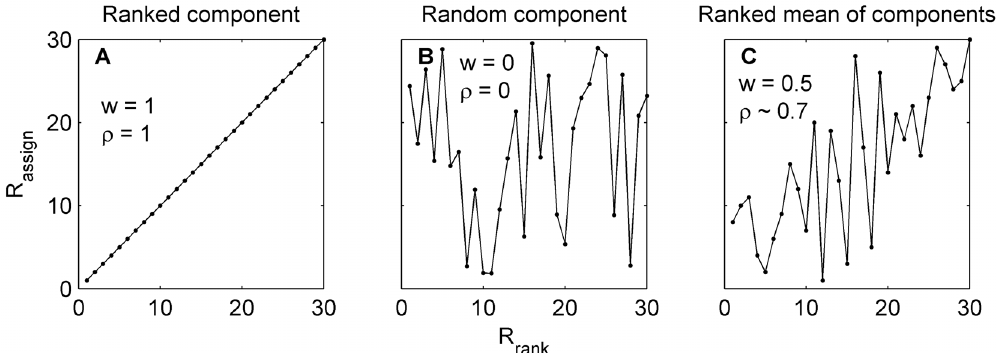
Figure 3. Assigning anisotropic tuning parameters based on a neuron’s preferred direction. The tuning parameter value (bandwidth or peak spiking rate) given to each neuron in order of distance from cardinal may vary from being fully sorted (A) to entirely random (B). Intermediate levels of orderliness may be generated by a weighted average of the two extreme configurations by factor w ; this is exemplified in (C) with w=0.5, resulting in a rank assignment with Spearman rank correlation, r < 0.7.